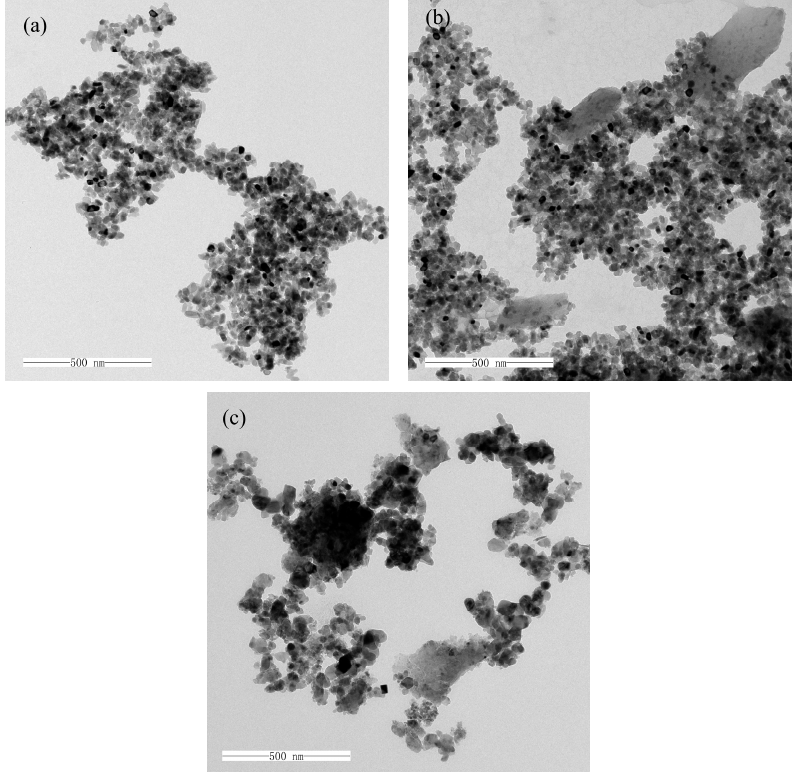
Figure 4. TEM of Mn-based bimetallic nanocatalysts. temperature on NO conversion. (a) Mn − Ce/TiO 2 ; (b) Mn − Co/TiO 2 ; and (c) Mn − Fe/TiO 2.